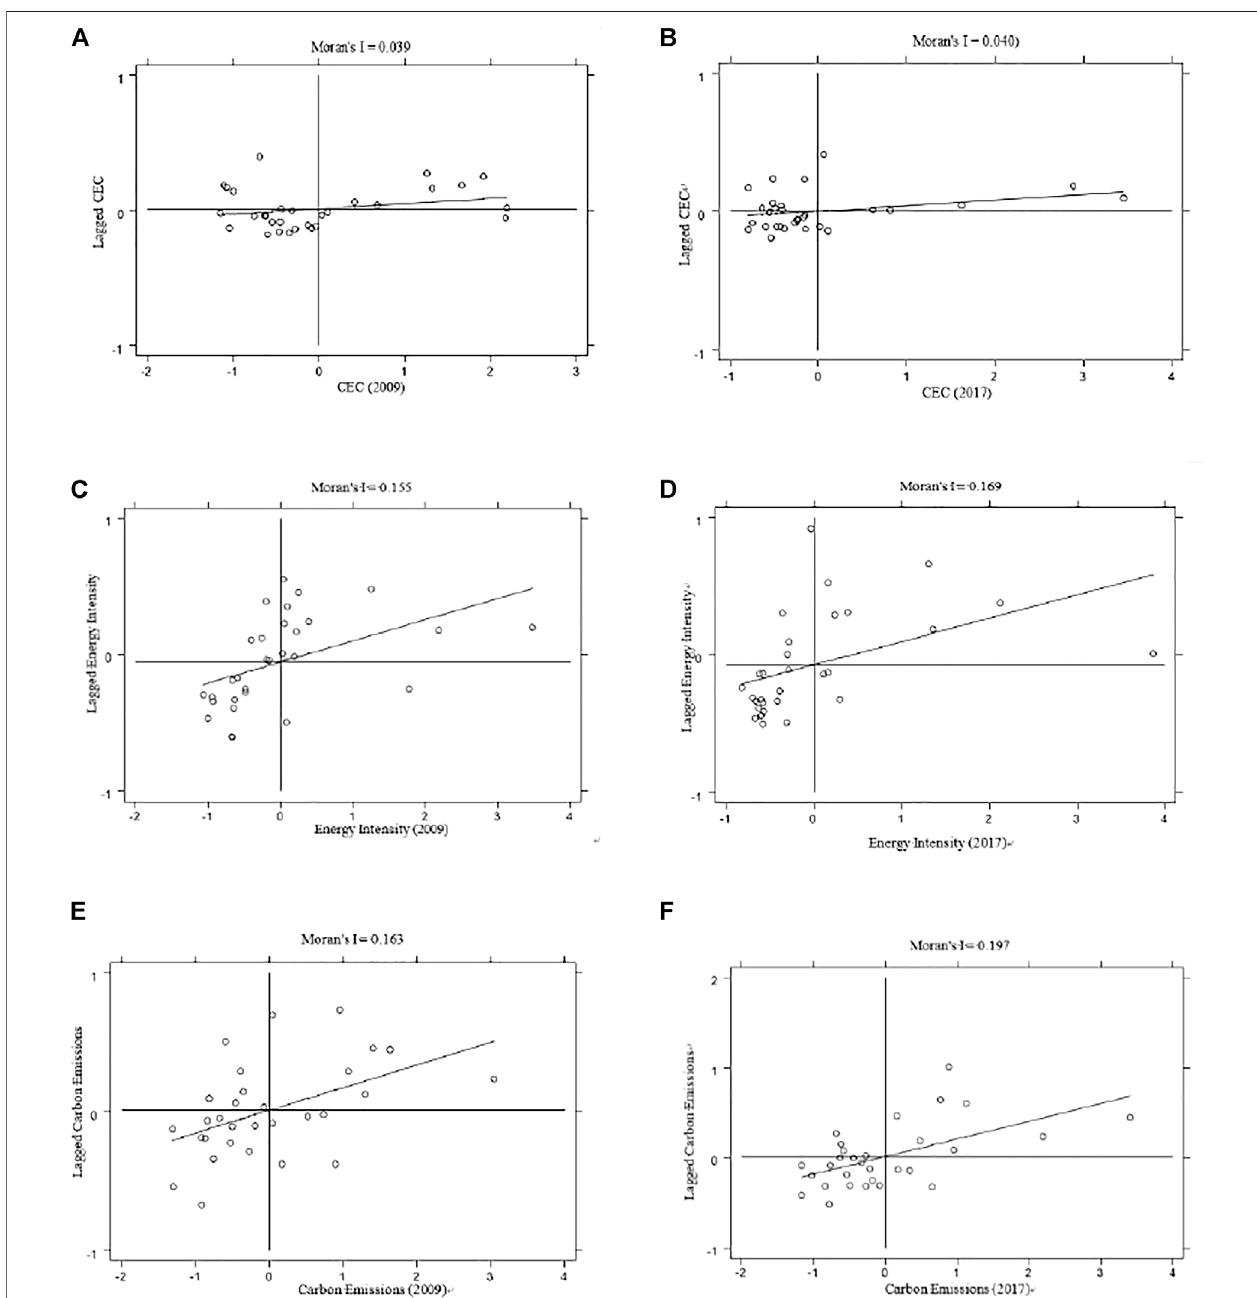
FIGURE 2 | Scatterplots of Moran ’ I of CEC, Energy intensiy and Carbon emissions for 2009 and 2017.